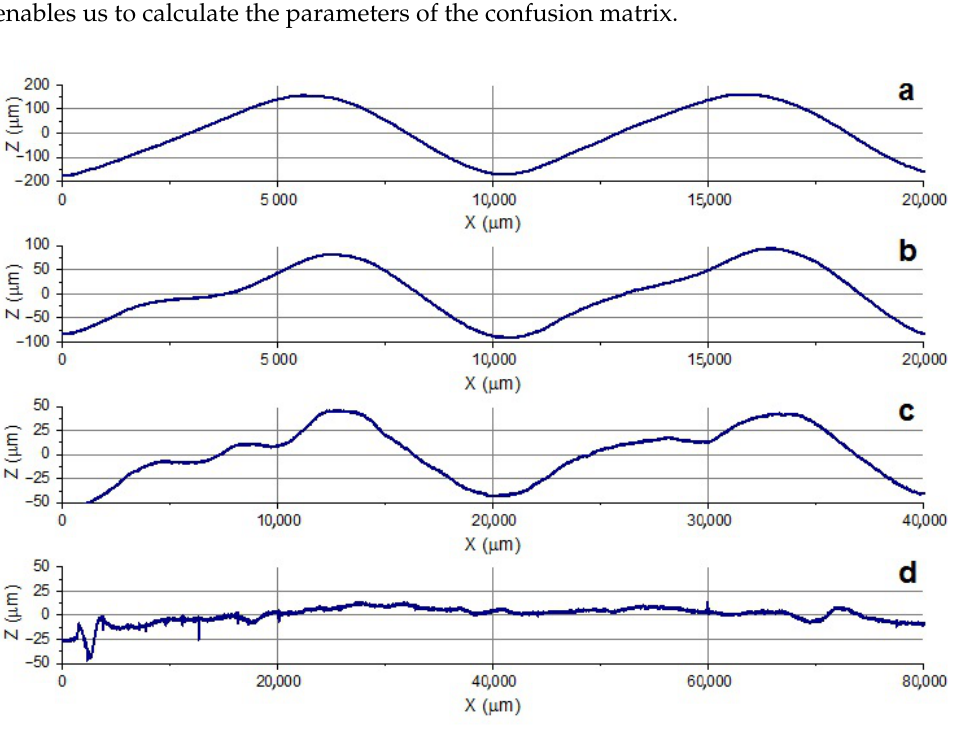
Figure 6. Examples of profiles with the textures obtained by Waveshape: ( a ) good similarity to the target texture, ( b ) moderate similarity to the target texture, ( c ) weak similarity to the target texture, ( d ) texture